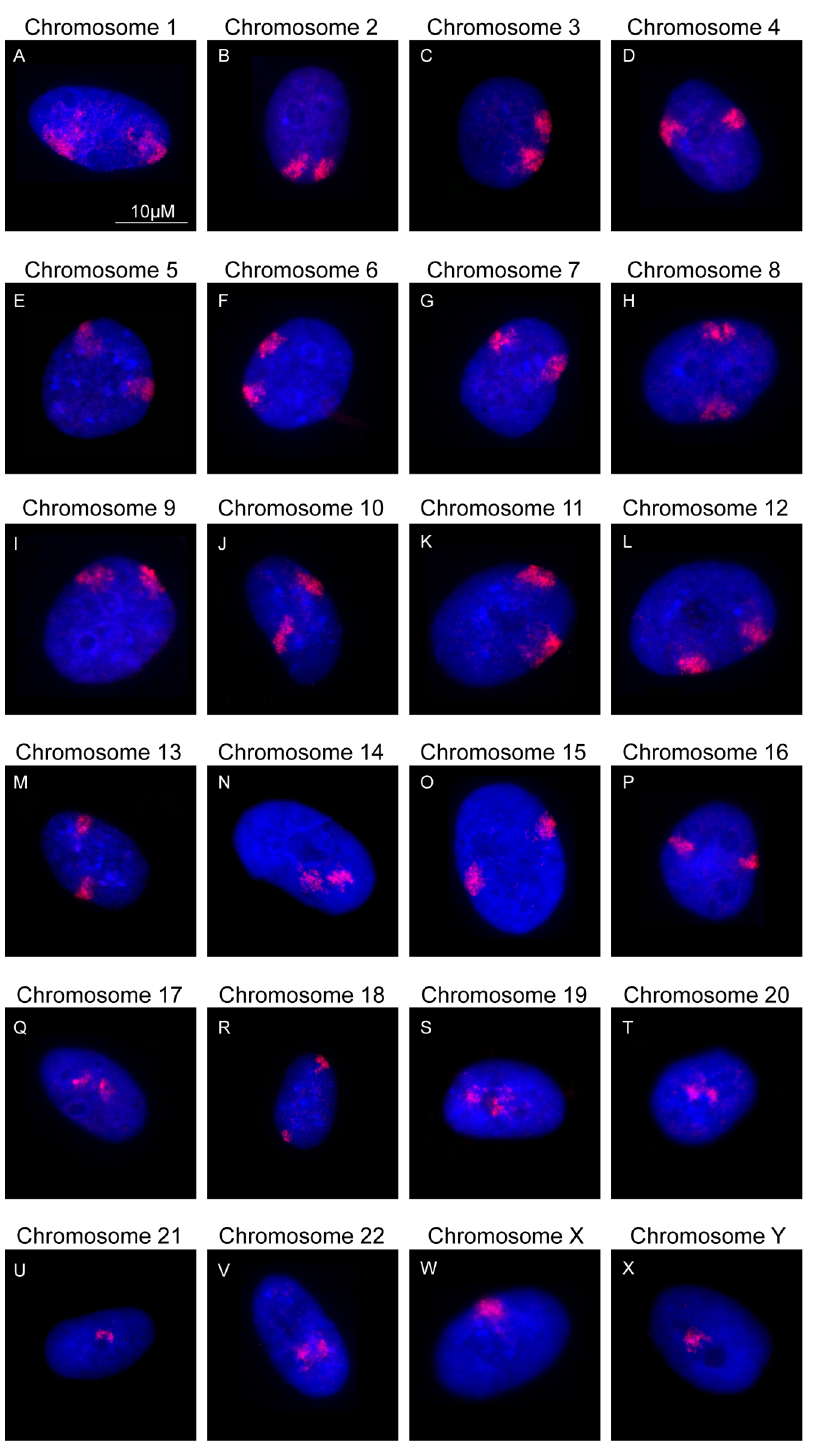
Figure 1. Positions of all chromosomes in normal proliferating human dermal fibroblasts: Images displaying the spatial arrangement of each of the human chromosome territories (in red) in interphase nuclei (stained in blue) of fibroblasts. The numbers on the top of each nucleus indicates the chromosome to which a specific probe was hybridized to, as revealed by FISH. Scale bar=10 m M.